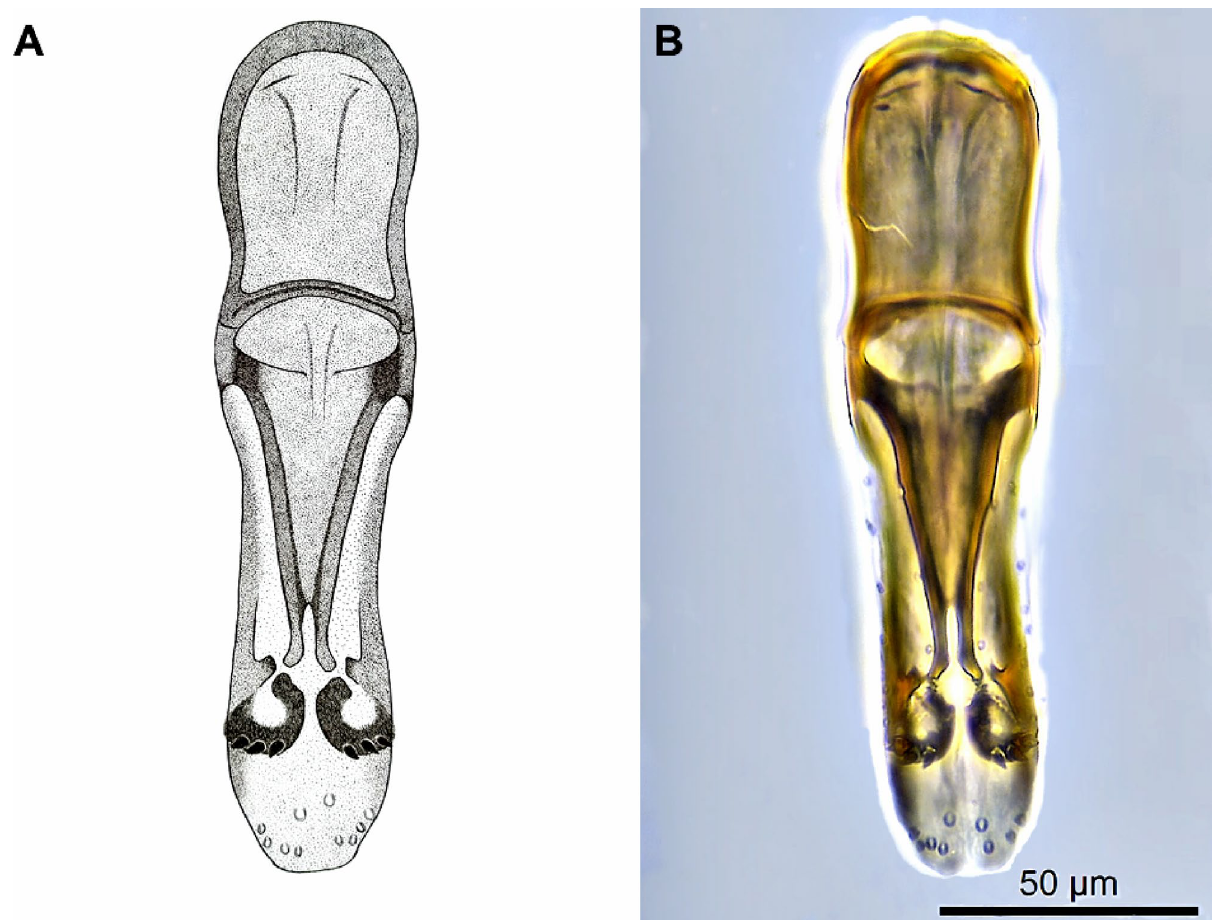
Figure 3. Genitalia of the male of Telenomus remus . ( A ) Schematic illustration. ( B ) Canada balsam preparation.